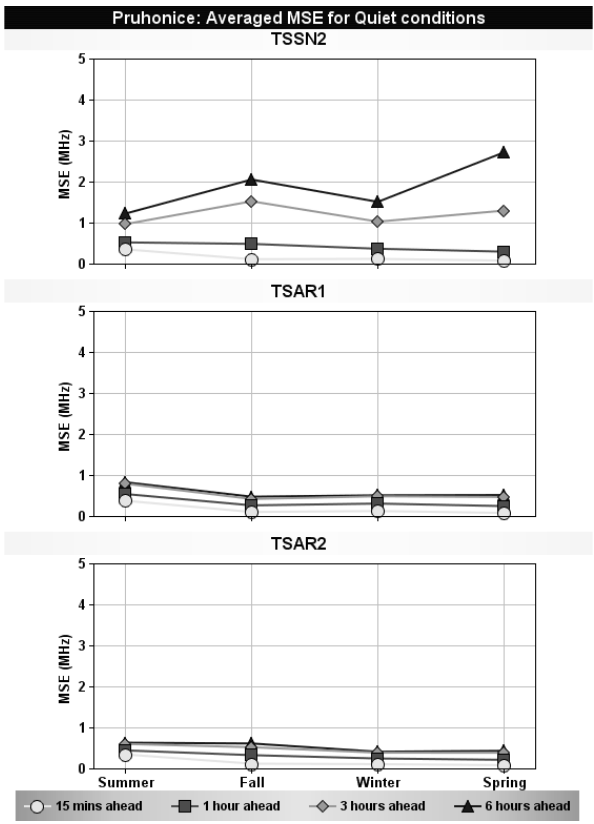
Fig. 8. The same as Fig. 7 for Pruhonice location.